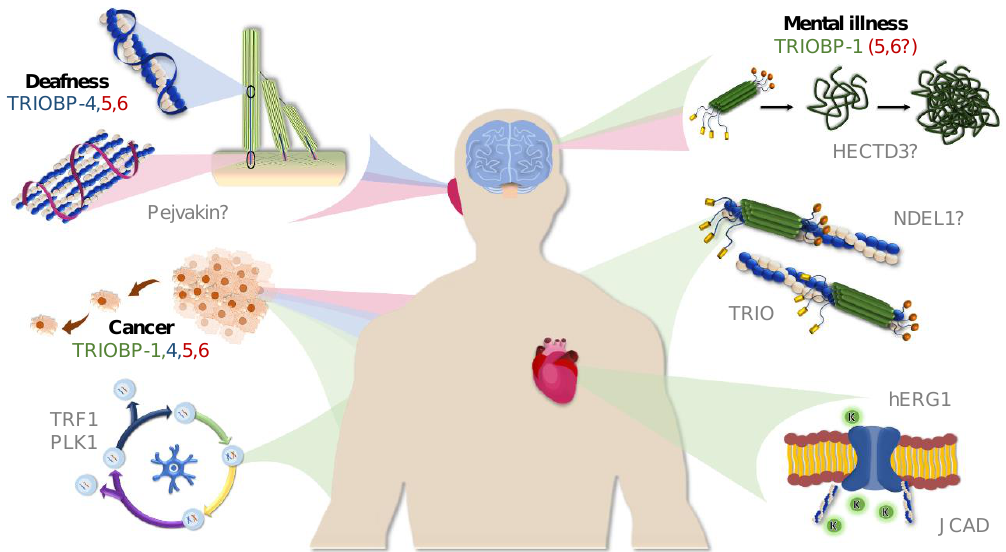
Figure 5. Illustrated representation of the expression and roles of TRIOBP-1 (green), TRIOBP-4 (blue), and TRIOBP-5 / 6 (red). Clockwise from top: Aggregation of TRIOBP-1 in the brain and mental illness; Role of TRIOBP-1 in F-actin stabilization throughout the body; Linking of actin to ion channel function in the heart by TRIOBP-1; role of TRIOBP-1 in the cell cycle; Importance of all major TRIOBP isoforms in metastasis; Distinct roles of TRIOBP-4 and TRIOBP-5 in the stereocilia of the inner ear and deafness. Protein interaction partners implicated in the various processes are indicated in